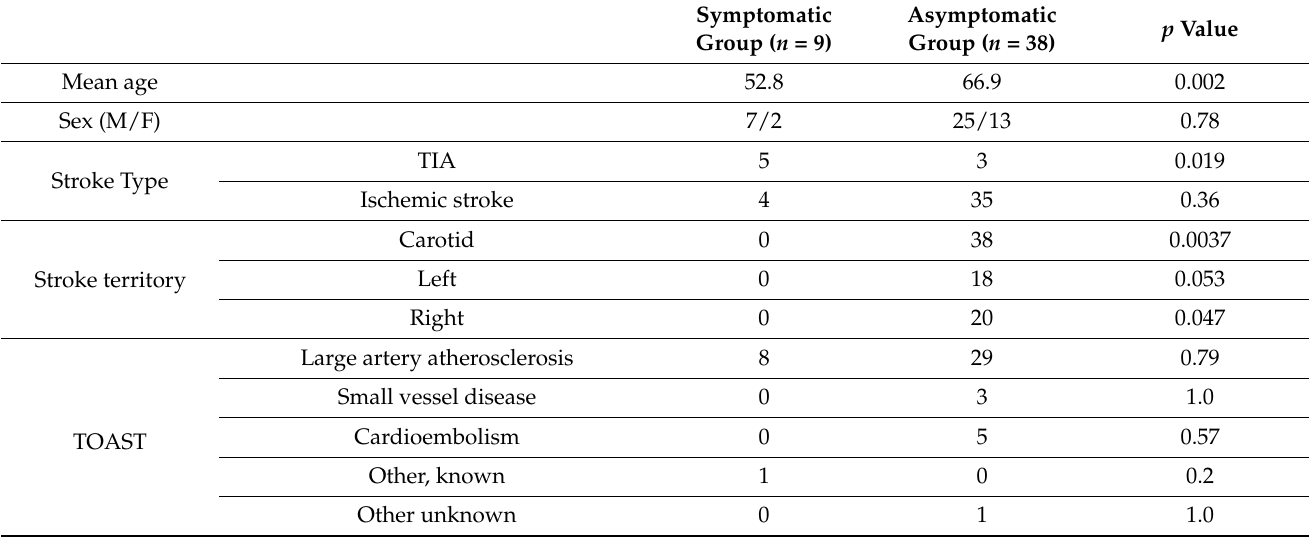
Table 2. The main demographical and clinical characteristics of the patient groups with associated symptomatic and asymptomatic subclavian